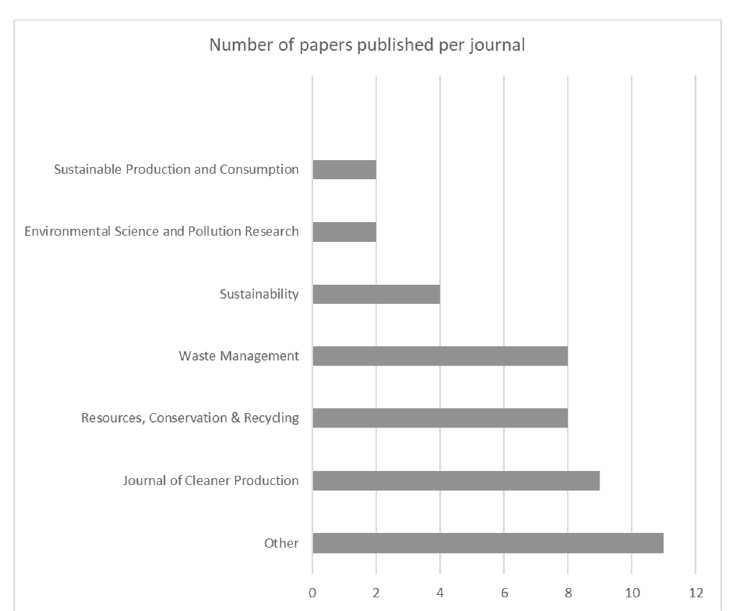
Figure 5. Number of papers published per journal.